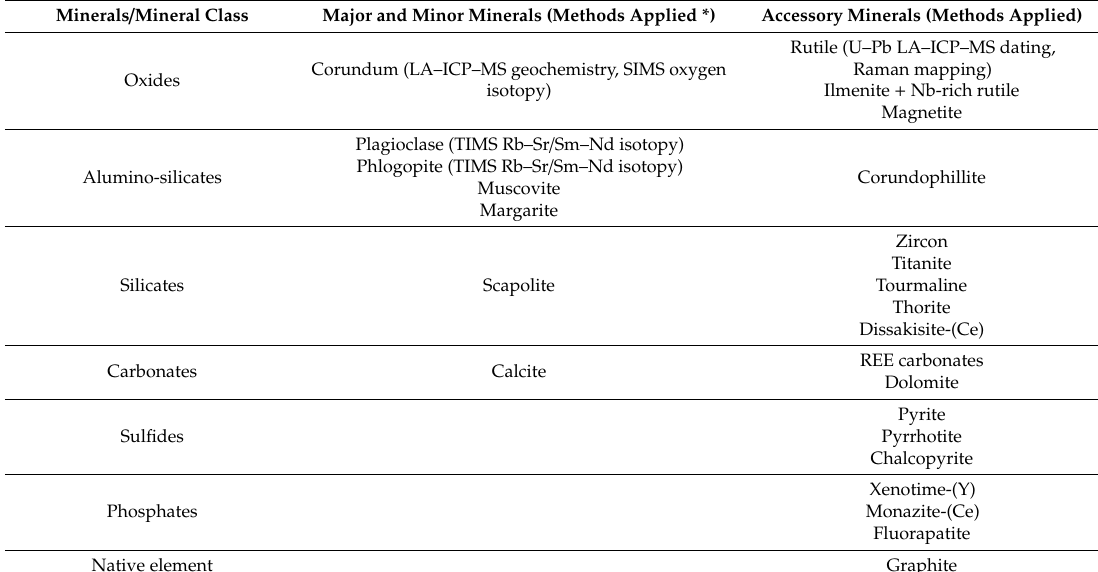
Table 1. List of major, minor and accessory minerals from the Snezhnoe deposit.